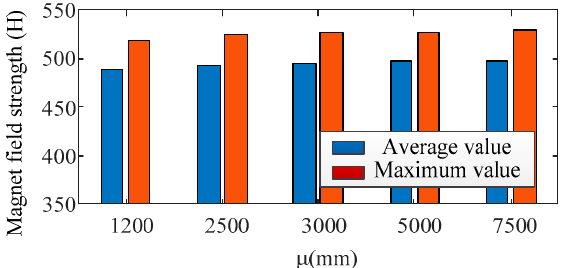
Figure 16. Magnetic field strength curves of shields of MnZn with different depths and different relative permeabilities.